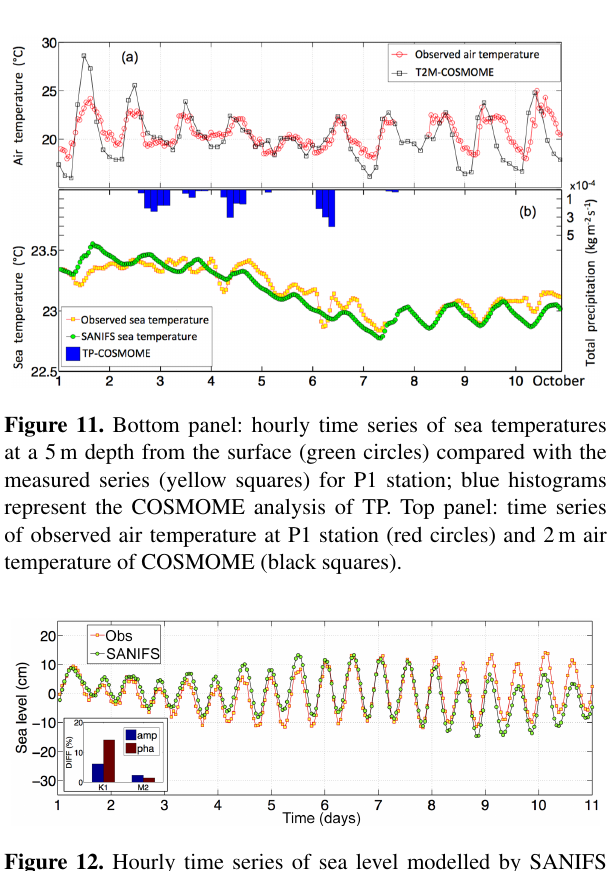
Figure 12. Hourly time series of sea level modelled by SANIFS (green circles) and measured by P1 station (yellow squares). The box in the bottom left reports the tidal analysis for the most signifi- cant components (K1 and M2) in terms of amplitude and phase.